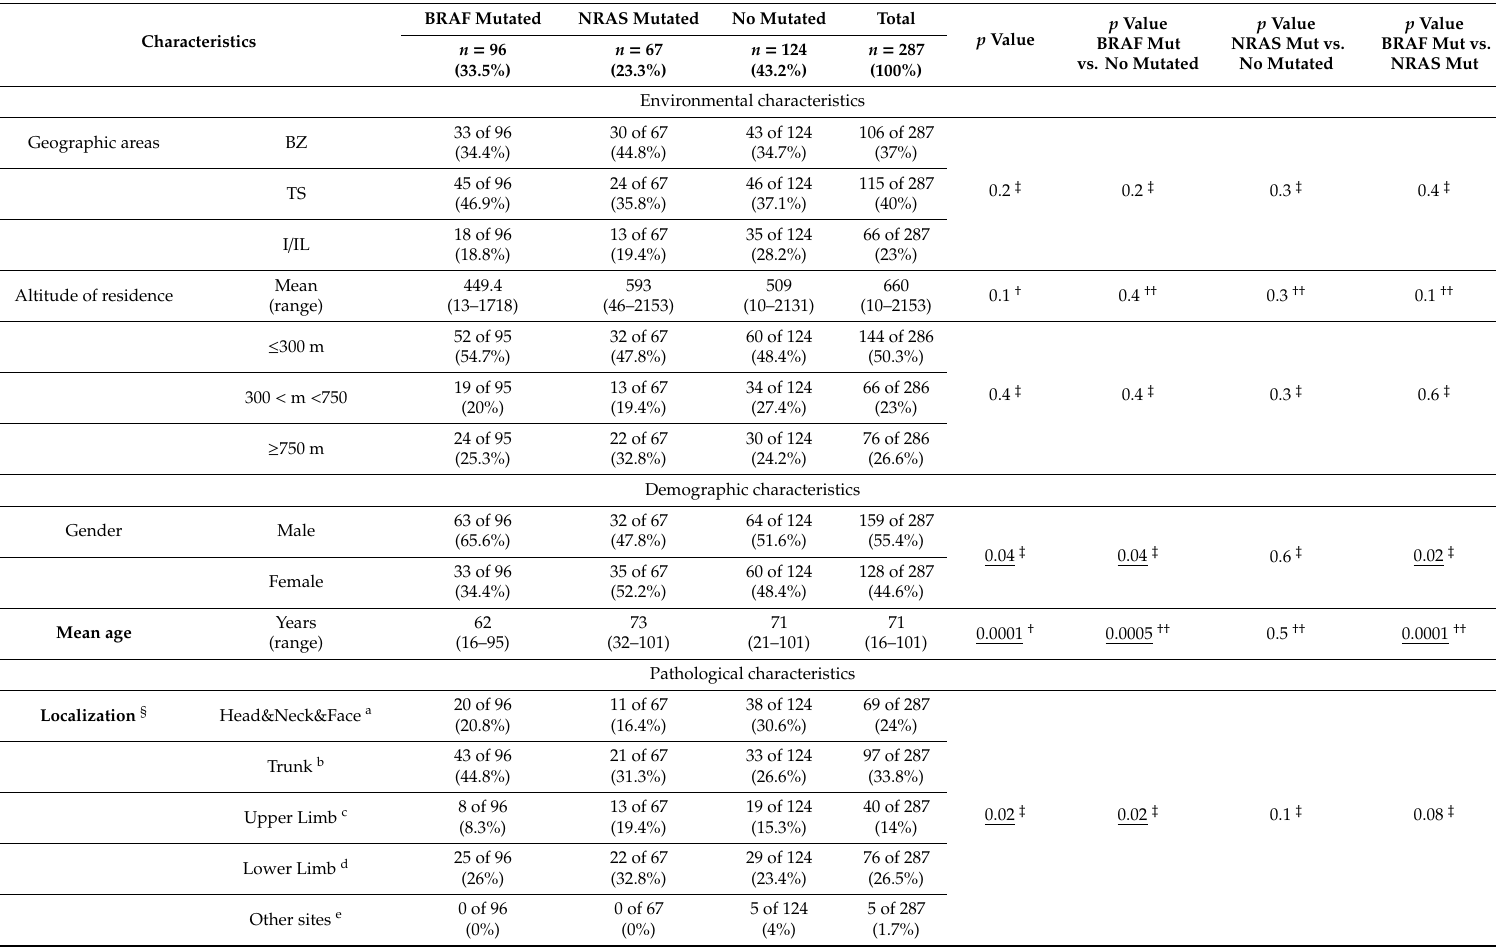
Table 3. Mutational status and patients’ cutaneous melanoma features. Underlined p highlights statistically significant results ( p <